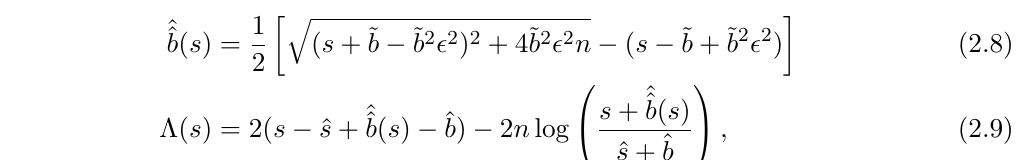
Figure 2 . Values of (a) Λ( s ) and (b) the conditional MLE yield s , computed from the model described in the text. In each plot, the simplified likelihood result (solid blue) is compared to an exact closed-form expression of the same quantity (dashed red), showing very close